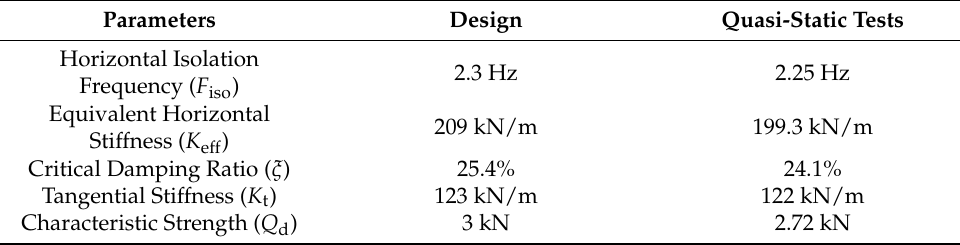
Table 2. LRB dynamic characteristics at design level [21].